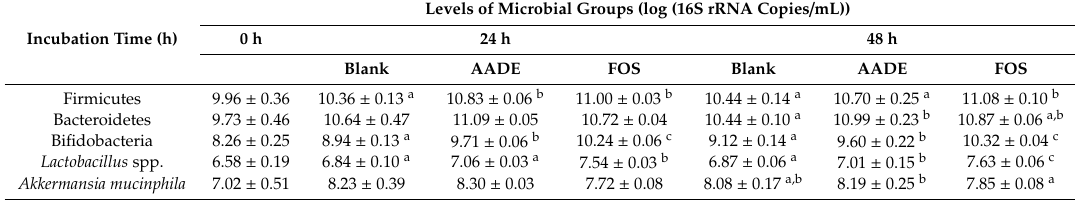
Table 2. Mean (± standard deviation) levels of microbial groups as measured via quantitative polymerase chain reaction (qPCR) after 0, 24, and 48 h of treatment of a simulated colonic microbiota with 5 g/L AADE (artichoke aqueous dry extract) or FOS (fructo-oligosaccharides). For each microbial group and within each time point (24 h or 48 h), a value indicated with a different letter (a, b, or c) indicates a statistical difference between AADE, FOS, and/or the blank, as tested with a two-way ANOVA with post-hoc Tukey test ( p < 0.05). In contrast, when at least one letter is shared between two treatments, there was no significant between these groups.